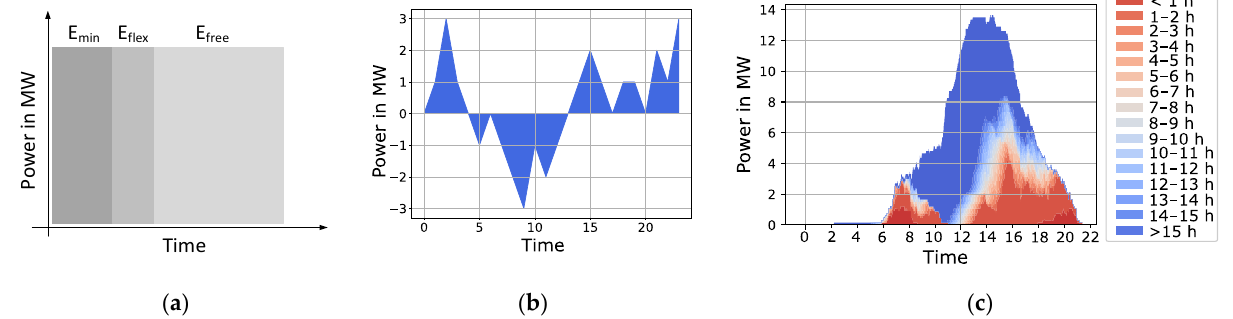
Figure 6. Common ways of flexibility visualization used in previous studies: ( a ) flex bars, ( b ) positive and negative flexibility over time, or ( c ) accumulated flexibility profile with time categories.